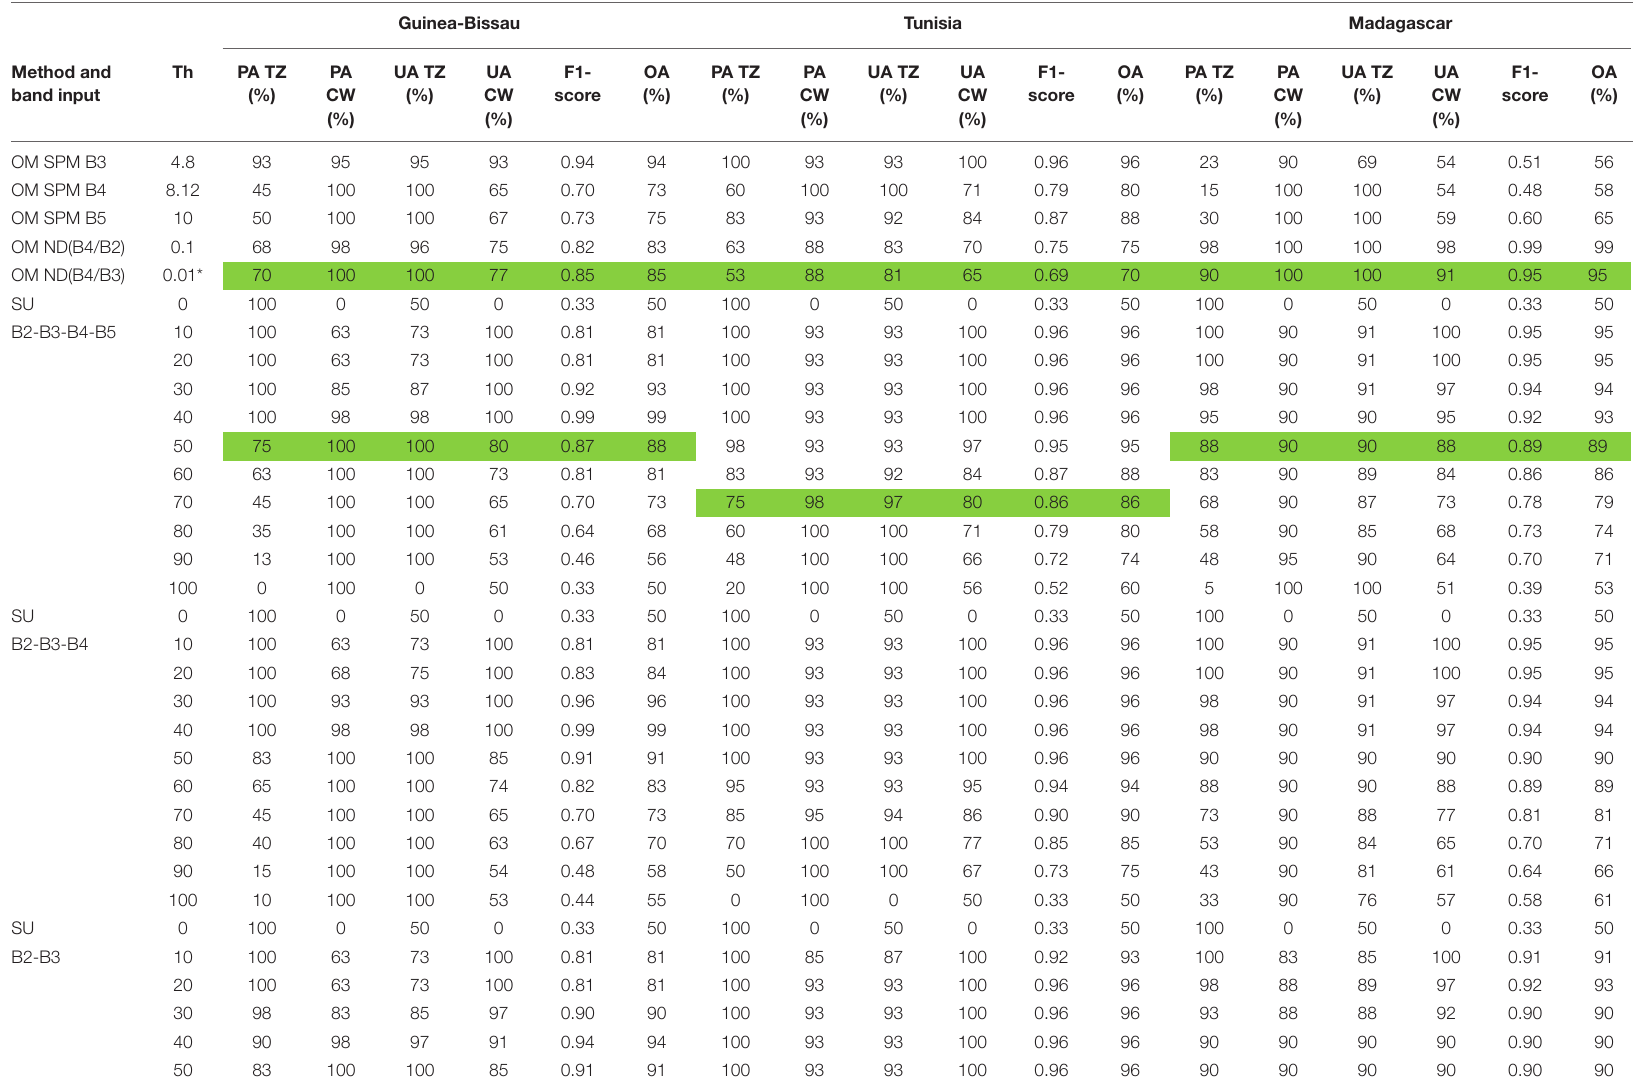
TABLE 2 | Accuracy scores of the best turbid zone (TZ) and clear water (CW) class separation using Otsu’s method (OM), spectral unmixing (SU), and Random Forest (RF), reported in producer’s accuracies (PA), user’s accuracies (UA), F1-scores, overall accuracies (OA) in Guinea-Bissau, Tunisia, and west coastline of Madagascar study